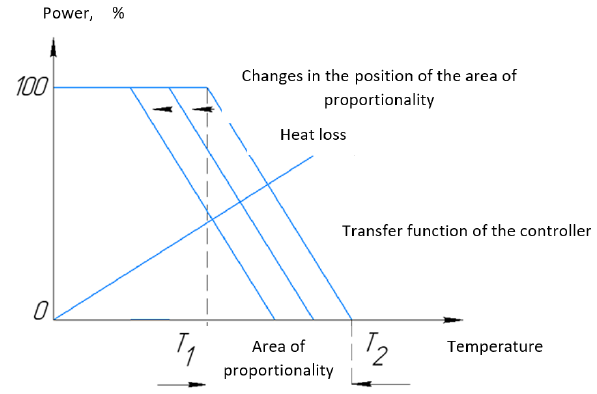
Figure 12. Effect of proportional band shift.